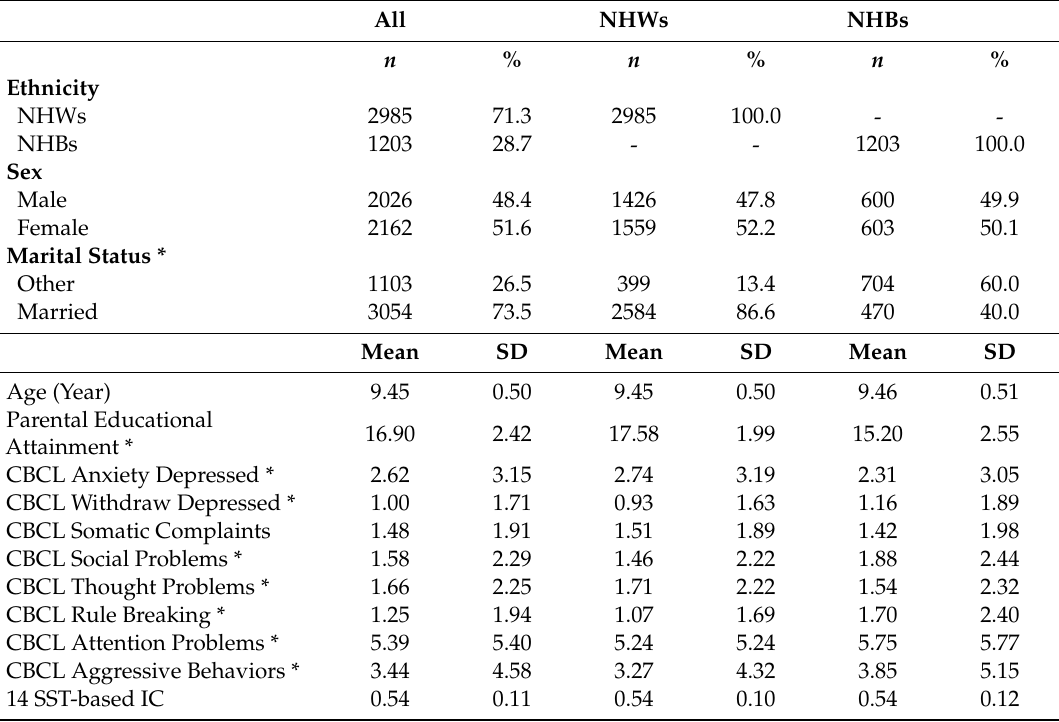
Table 1. Data overall and by race / ethnicity ( n =